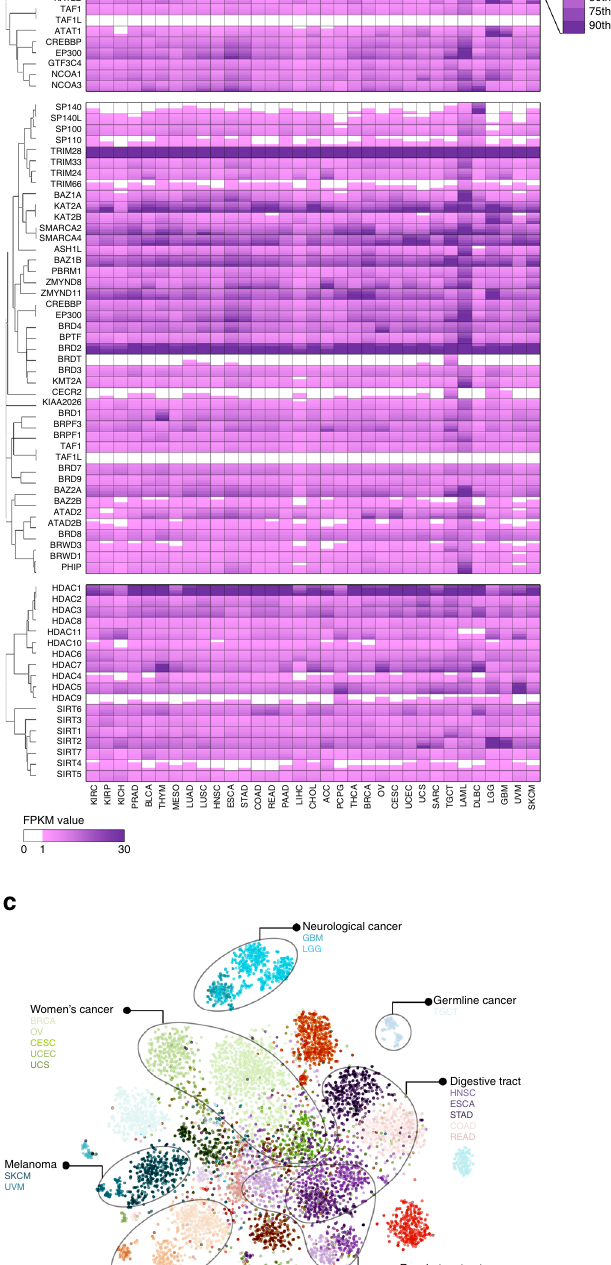
that co-altered with HAMPs (Supplementary Data 7). In addition, several HAMPs ( SP140 / SP140L / SP100 / SP110 , HADC10 / BRD1 , HDAC8 / TAF1 , and NCOA3 / ZMYND8 ) were co-altered due to their genomic proximity. Among the three types of HAMPs, BRD proteins showed the highest frequency of recurrent SCNAs, whereas HATs presented few recurrent events (Fig. 2c). Five HDAC genes ( HDAC2 , HDAC4 , HDAC5 , HDAC10 , and SIRT3